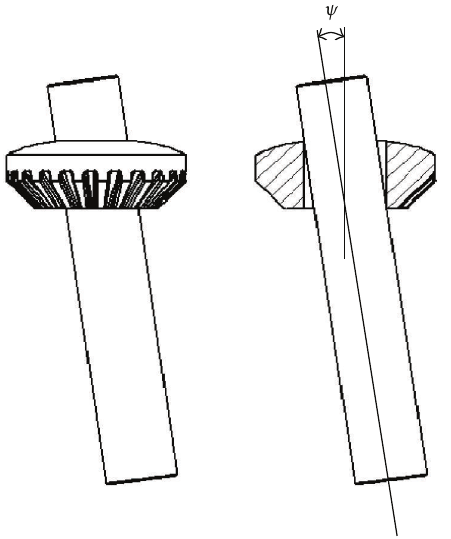
Figure 5: Over-centre mechanism between the satellite pinion and satellite-carrier axis; 𝜓 denotes the angular eccentricity.